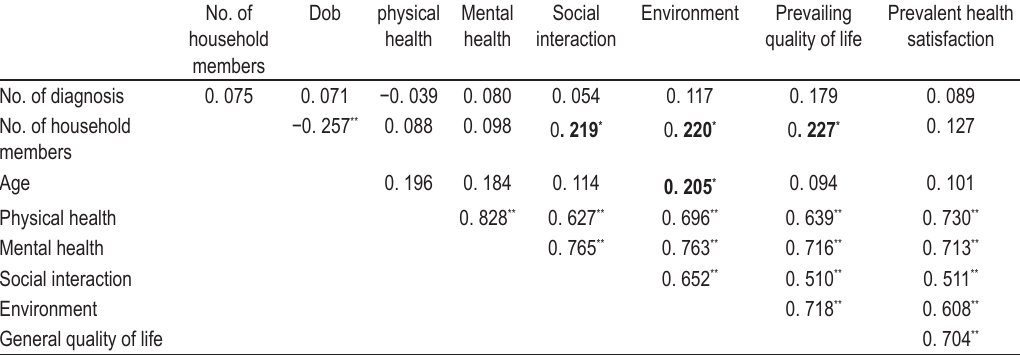
TABLE 2. Correlations among the number of diagnoses, household members, and age with the results based on WHOQOL-BREF